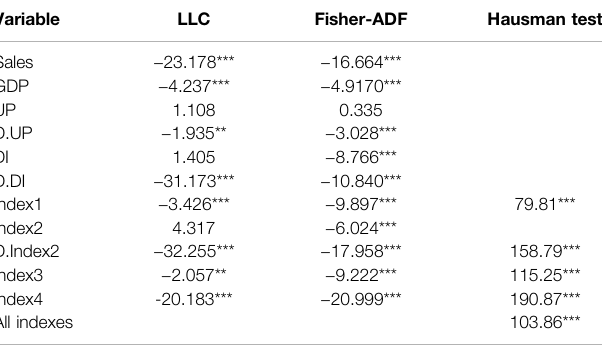
TABLE 3 | Unit root test results for each